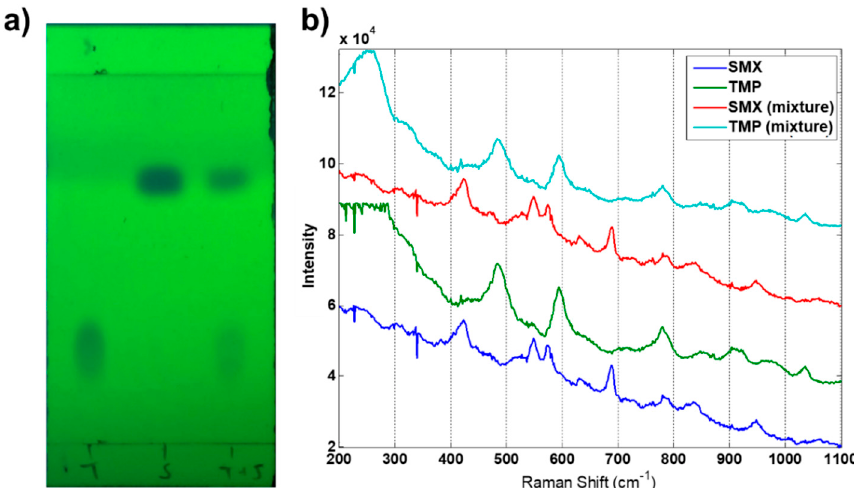
Figure 4. ( a ) TLC plate after analysis in UV chamber and ( b ) SERS spectra of the chromatographic bands observed in the plate.